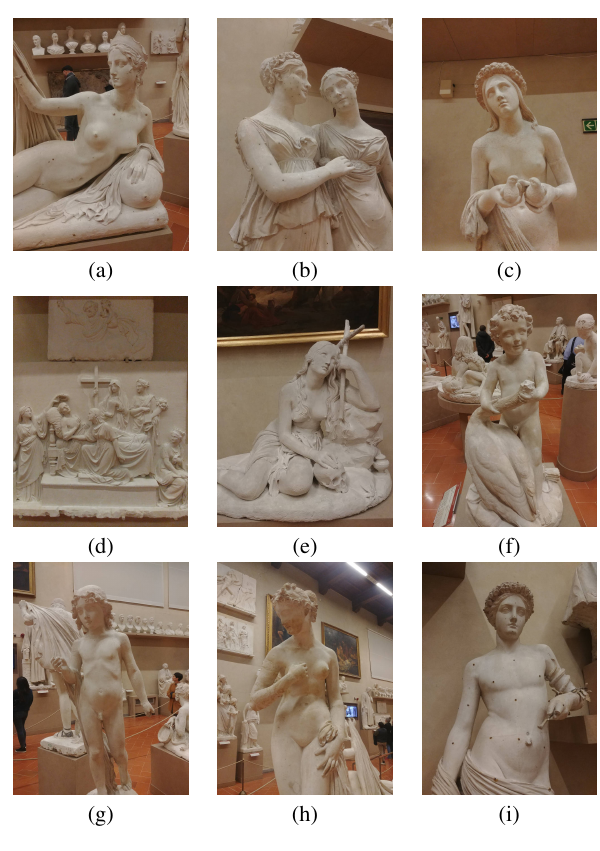
Figure 3. Statues considered as case studies.